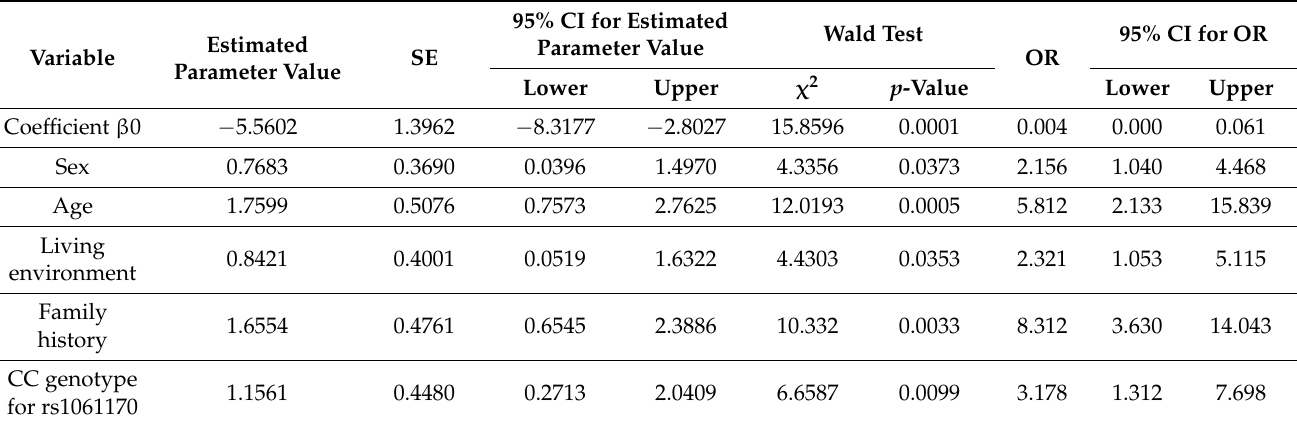
Table 4. Results of logistic regression analysis based on sex, age, living environment, and the CC genotype for the rs1061170